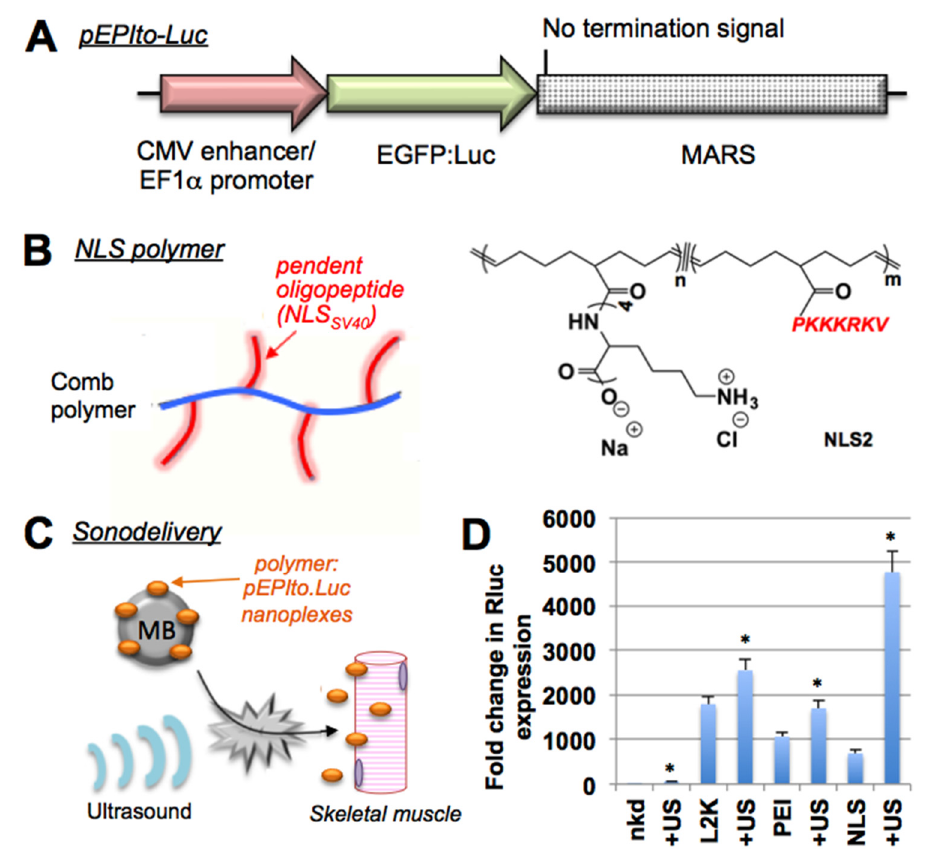
Figure 1. ( A ) pEPIto-Luc, containing a cytomegalovirus (CMV) enhancer and an